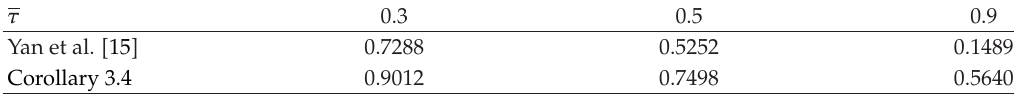
Table 2: Allowable upper bounds of τ 2 for di ff erent τ .